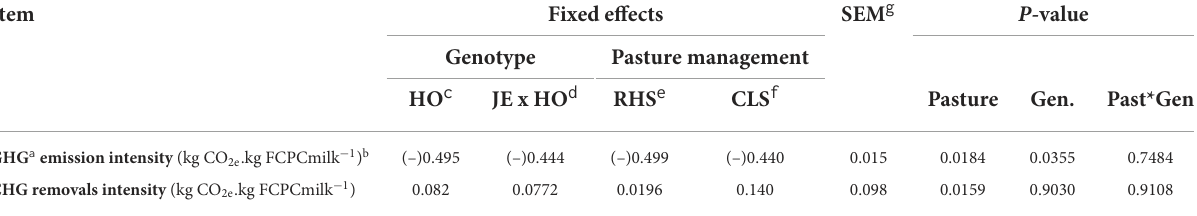
TABLE 6 Emissions and removal intensity of GHG per milk yield (FCPCmilk) for two cow genotypes and two levels of intensification in grazing systems.